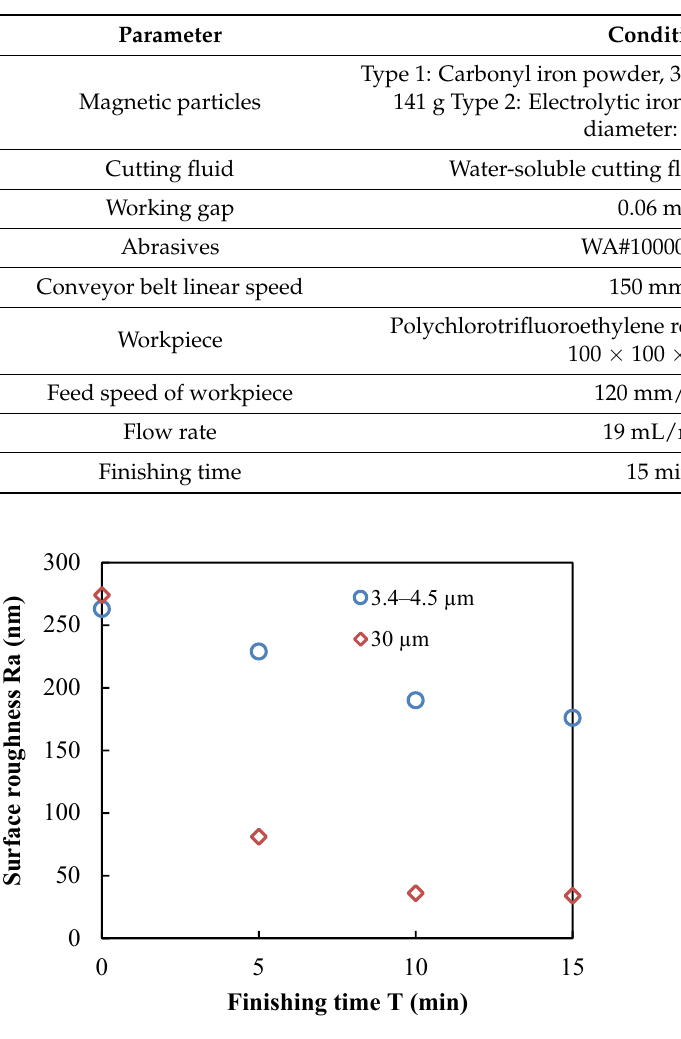
Table 2. Experimental conditions.